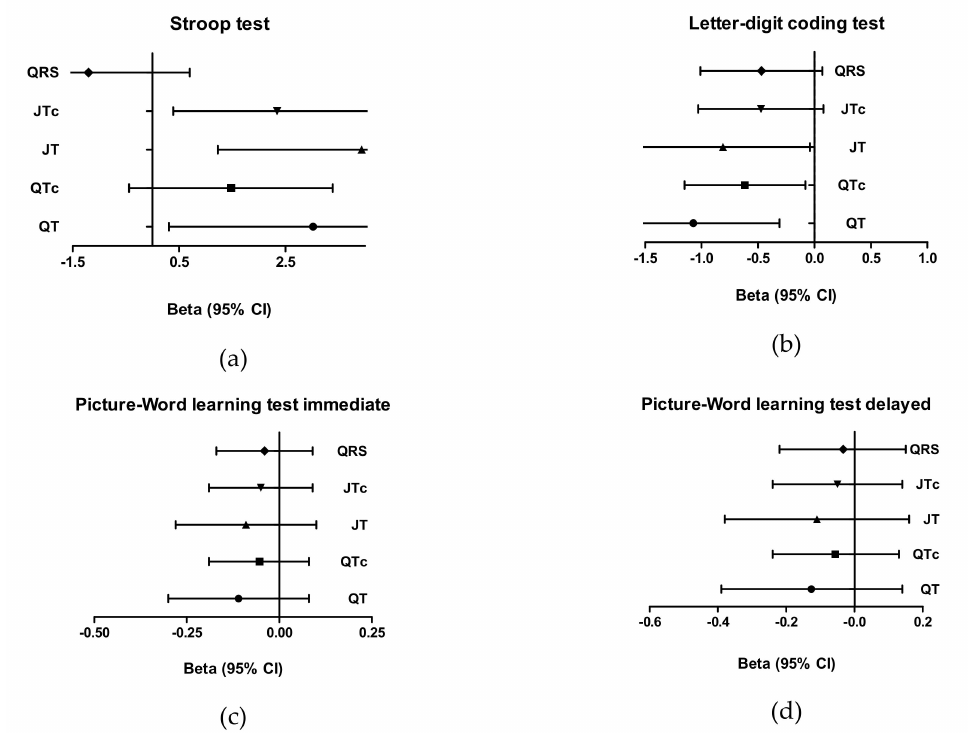
Figure 1. Associations between QT, QTc, JT, JTc, and QRS intervals, and cognitive tests as Beta (95% CI) (fully adjusted model). ( a ) Association between QT, QTc, JT, JTc, QRS intervals and the Stroop Test. ( b ) Association between QT, QTc, JT, JTc, QRS intervals and the Letter–Digit Coding Test. ( c ) Association between QT, QTc, JT, JTc, QRS intervals and the Picture–Word Learning Test immediate. ( d ) Association between QT, QTc, JT, JTc, QRS intervals and the Picture–Word Learning Test